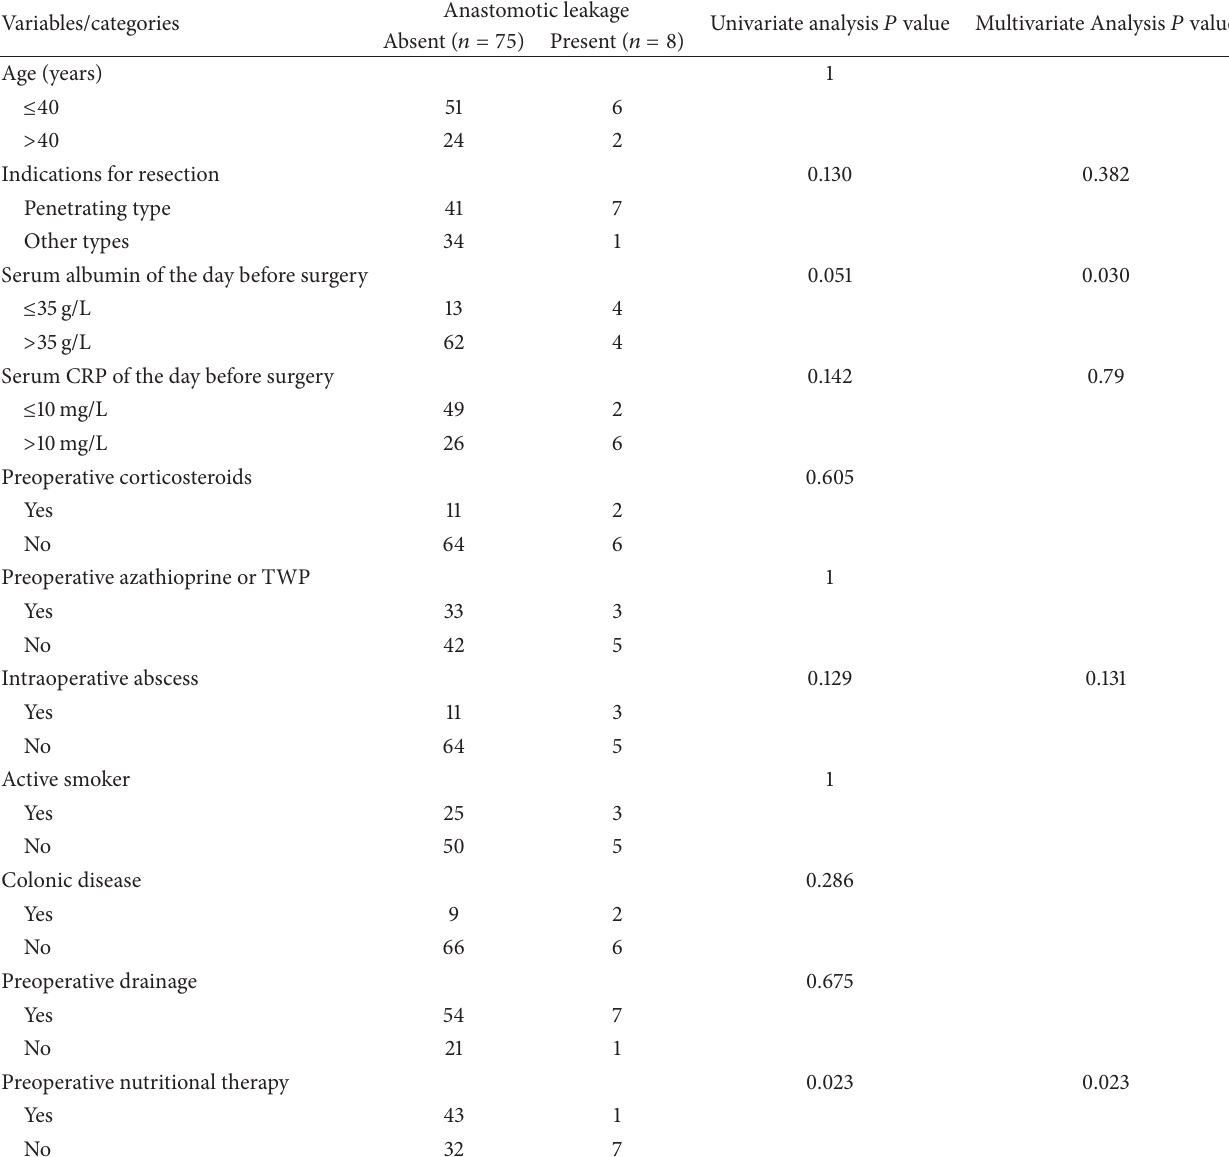
Table 6: Univariate analysis and multivariate analysis for predictive factors of anastomotic leakage.